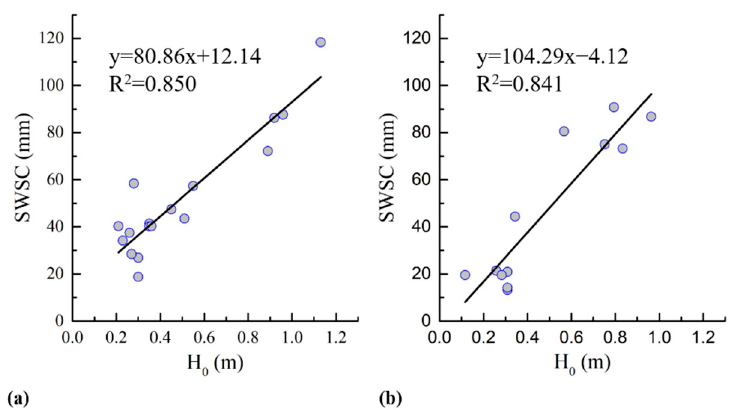
Figure 8. The linear relationship between the initial groundwater depth ( H 0 ) and the soil water storage capacity, SWSC : ( a ) in the HQW site, ( b ) in the BTQ site.